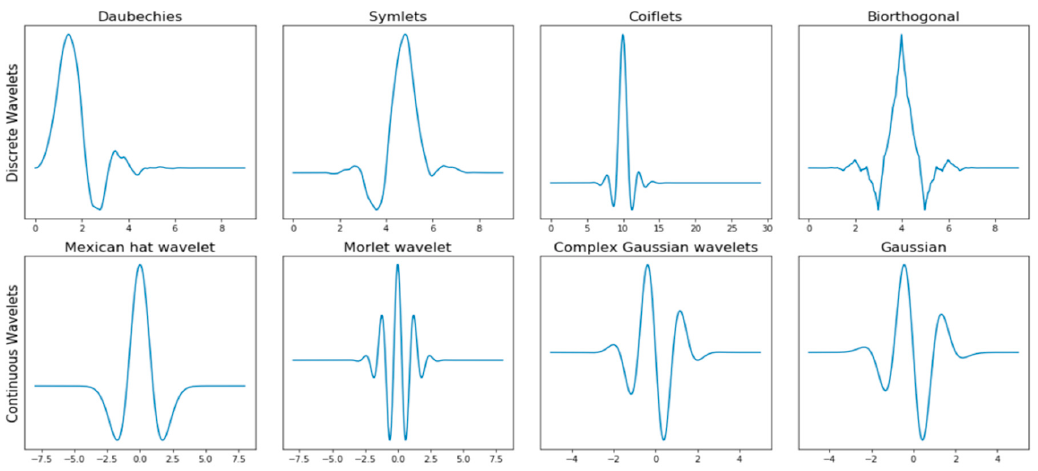
Figure 1. Wavelets families of discrete wavelets continuous wavelet.